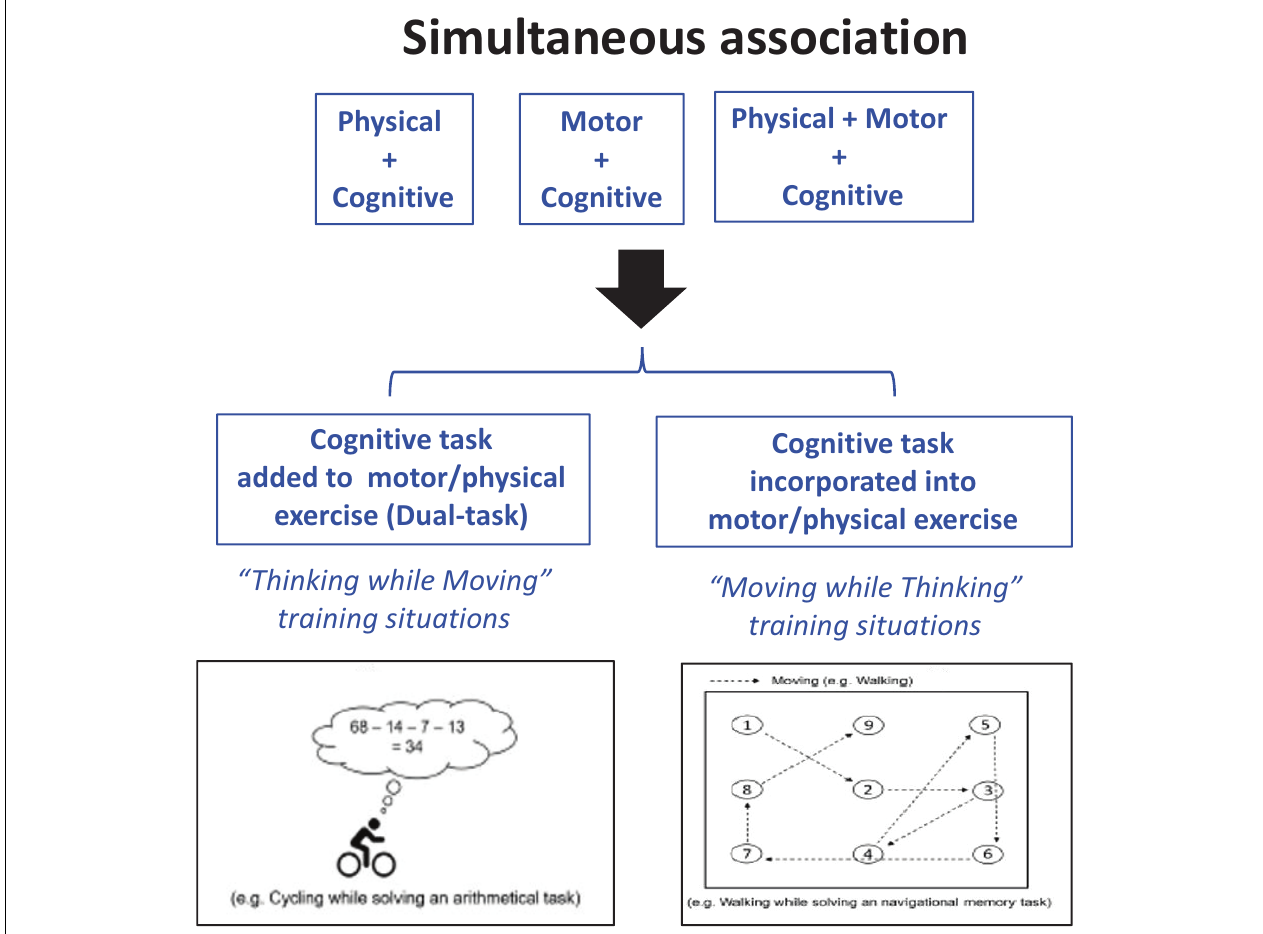
FIGURE 1 | Thinking while Moving and Moving while Thinking training situations, which are hypothesized to be two different kinds training conditions. In the former, the cognitive task is simply added to the motor/physical task, while in the latter, cognition is “incorporated” into motor tasks, making them more closely related to real daily life situations [modified from Herold et al.